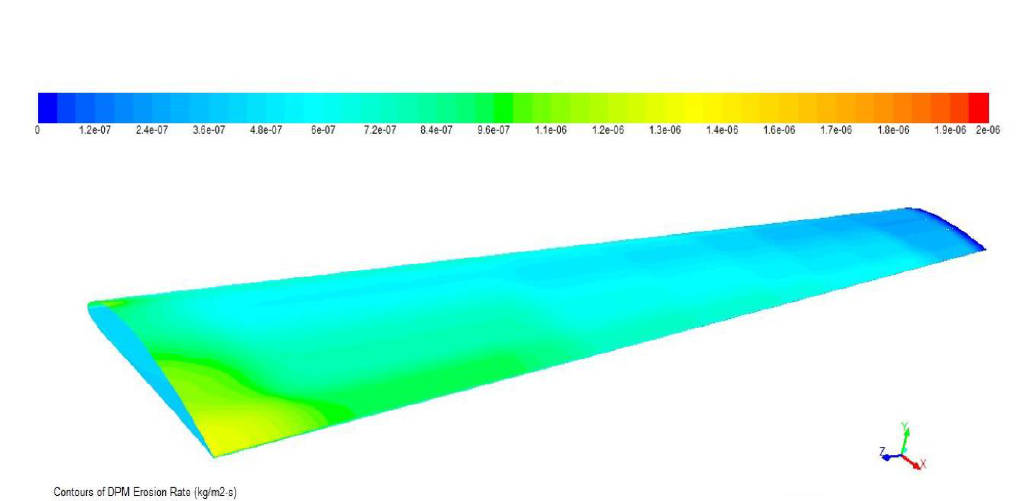
Figure 4: Erosion on wind turbine blade surface of glass fibre-resin for 60 ms −1 wind velocity and 90° impingement angle